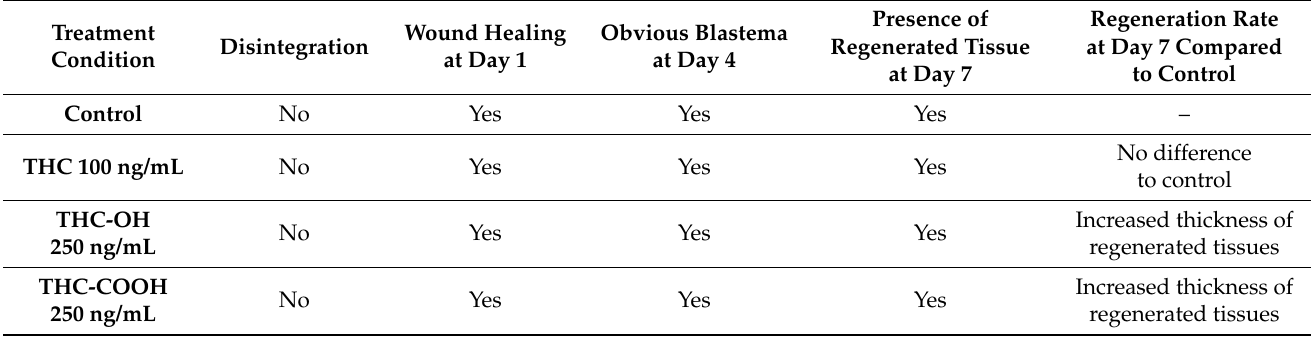
Table 2. Treatment with THC (100 ng/mL) resulted in no overall change in structure or regeneration compared to control. Conversely, increased cellular deposition was observed on the transection wound sites in response to 250 ng/mL doses of THC-OH and THC-COOH (shown in Figure 6). N = 3 per